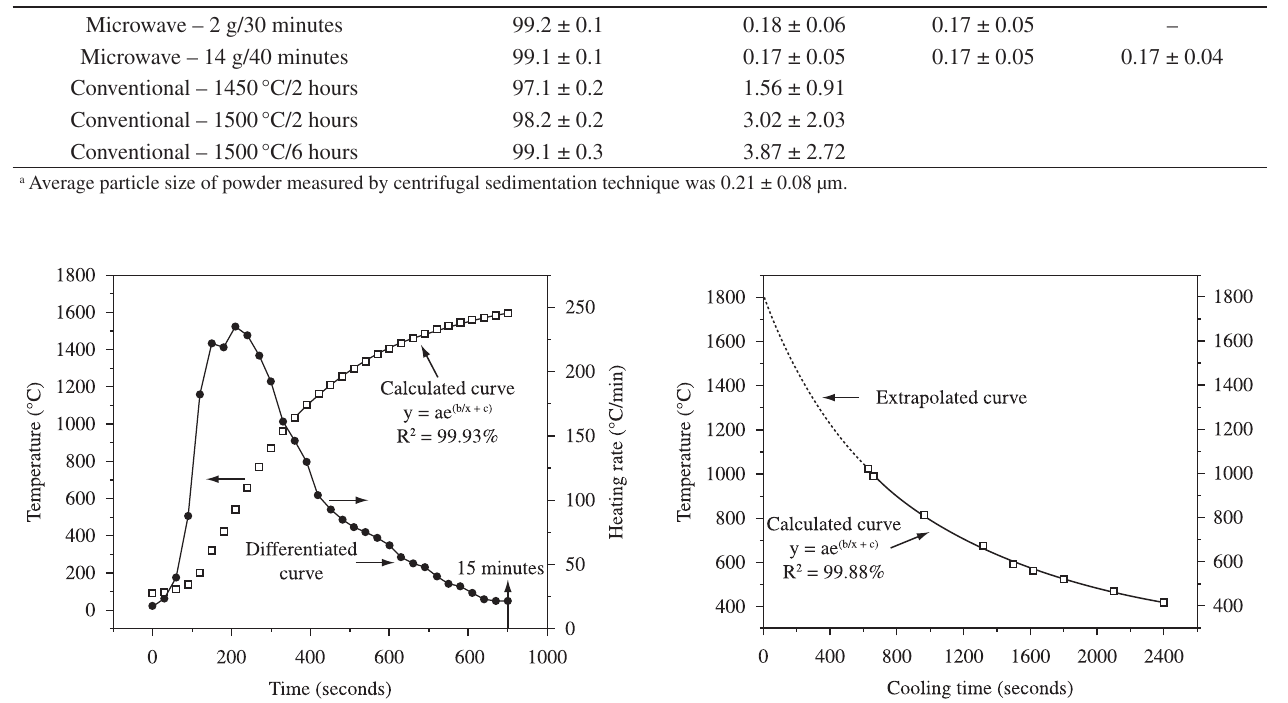
Figure 5. a) Temperature of the sintering arrangement and model fitted, which was calculated using the equation T = a exp (b/(c + t)), where a = 2020.87, b = -191.17 and c = -75.47 and b) Temperature of the sintering arrangement during cooling and model fitted, which was calculated using the equation T = a exp (b/(c + t)), where a = 64.83, b = 10035.12 and c =